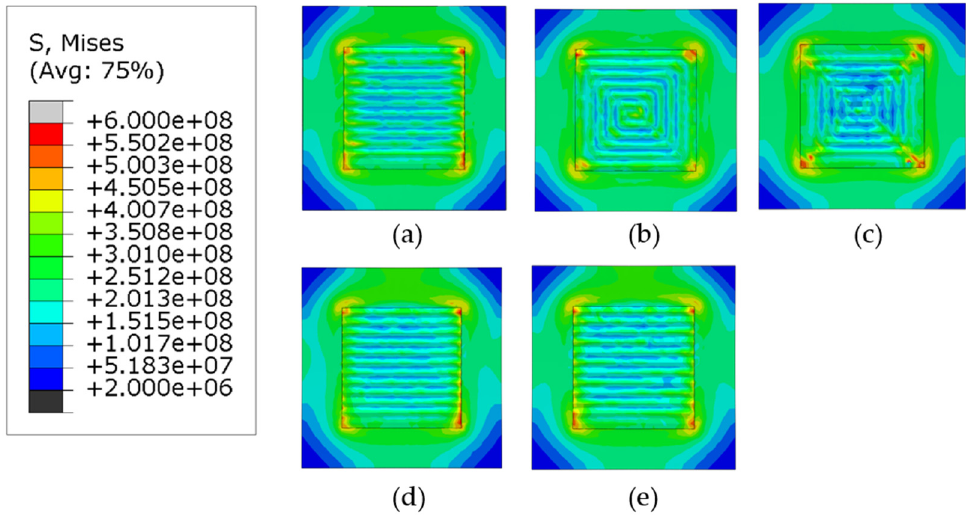
Figure 10. Mises stress distribution of different deposition patterns at the end of the simulation, when phase transformations are considered, (top view, unit: Pa); ( a ) alternate, ( b ) in–out, ( c ) out–in, ( d ) raster, ( e ) zigzag. ( d ) raster, ( e )